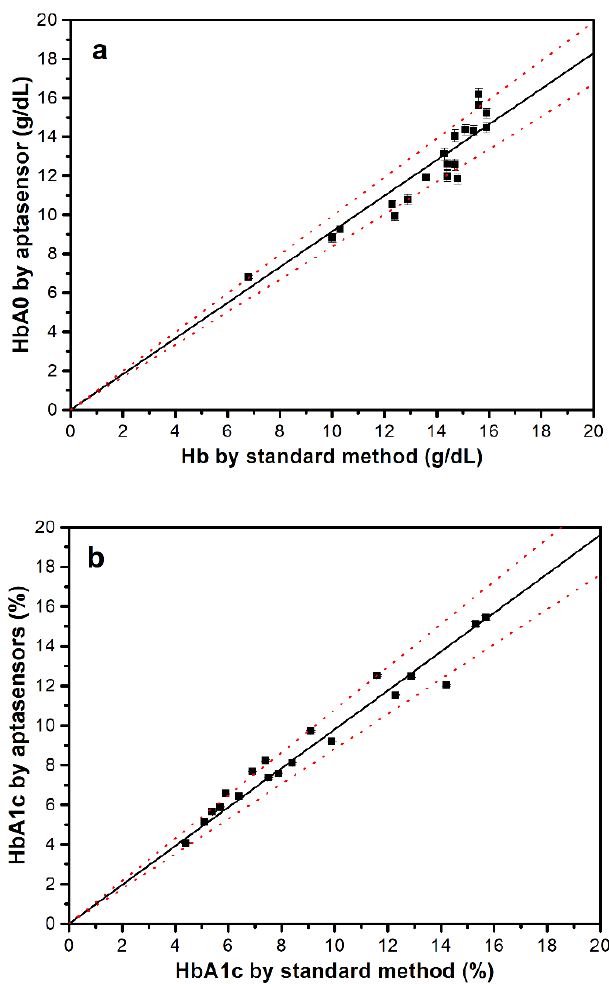
Figure 7. Correlation ( a ) between the aptasensor HbA0 concentrations and the standard measured total Hb concentrations and ( b ) between the HbA1c levels that are measured using the aptasensors and the standard method. The red dotted lines show 90% confidence intervals. All aptasensor data is presented as the average value for three measurements with one standard deviation. The RSDs for the HbA0 and HbA1c concentrations that are determined using their respective aptasensors are, respectively, less than 5% and 6%.